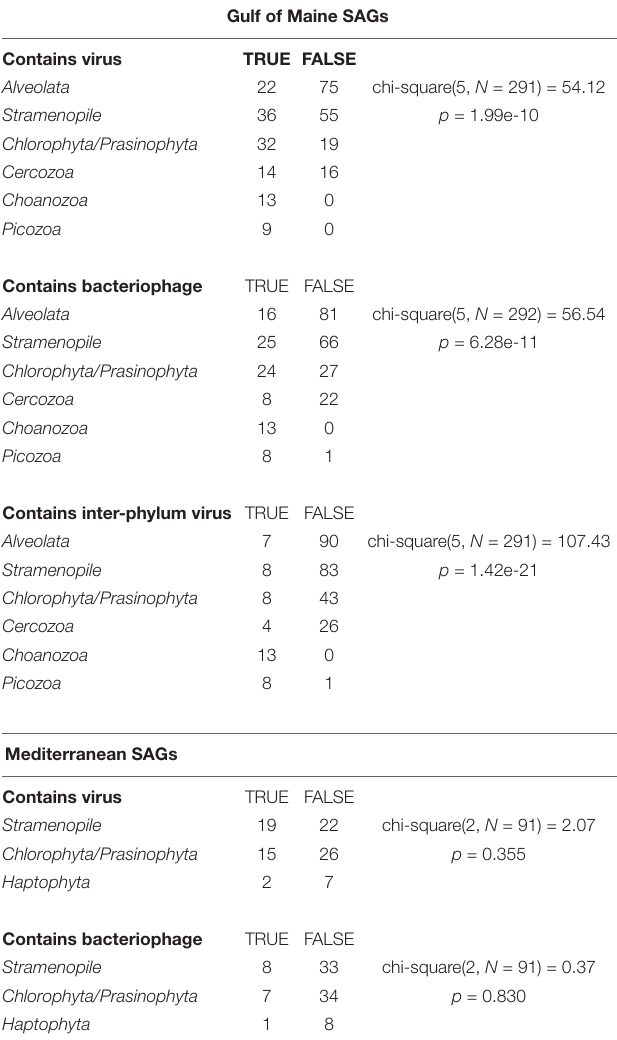
TABLE 1 | Results of chi-squared contingency tests of independence assessing the independence of the presence viruses in the most numerous taxa at each